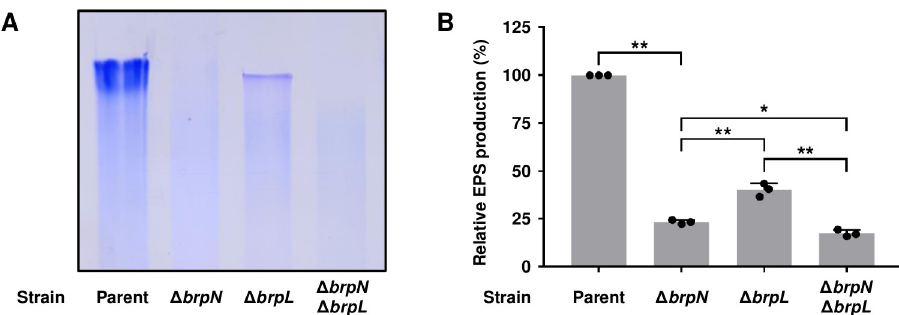
Fig 9. EPS production of the brpN , brpL , and brpN brpL double mutants. (A) EPS extracts were prepared from the V . vulnificus strains and then resolved on a 4% polyacrylamide gel by SDS-PAGE. The gel was stained with Stains-All and the gel representing the mean result from at least three independent experiments was photographed using a mobile camera. (B) EPS production of the mutants was quantified from the intensity of each lane, and the production of the parent strain was set as 100% in each experiment ( n = 3). Error bars represent the SD. Statistical significance was determined by the Student’s t test ( � , P < 0.05; �� , P < 0.005). Parent, parent strain; Δ brpN , brpN mutant; Δ brpL , brpL mutant; Δ brpN Δ brpL , brpN brpL double mutant.